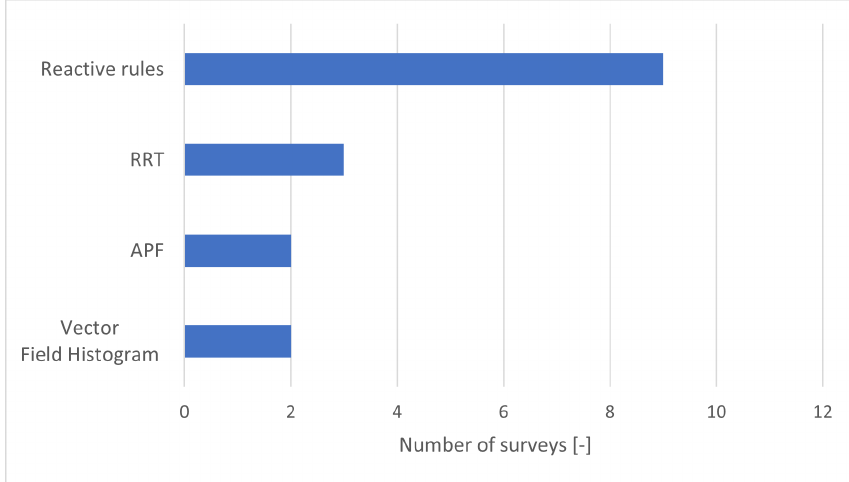
Figure 8. Classical methods in real applications.